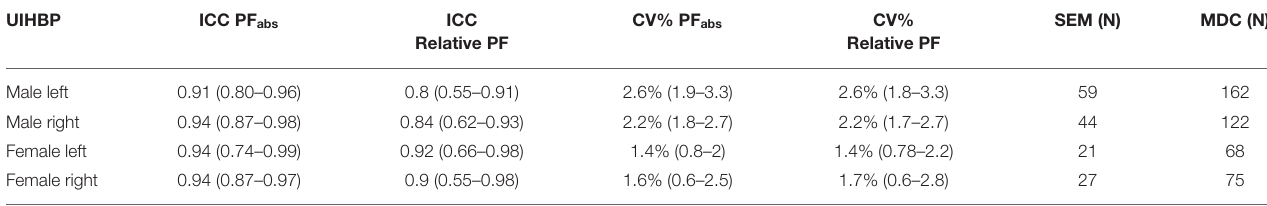
ICC, intraclass correlation coefficient; CV, coefficient of variation; PF abs , absolute peak force; PF, peak force; SEM, standard error measurement; MDC, minimal detectable change.